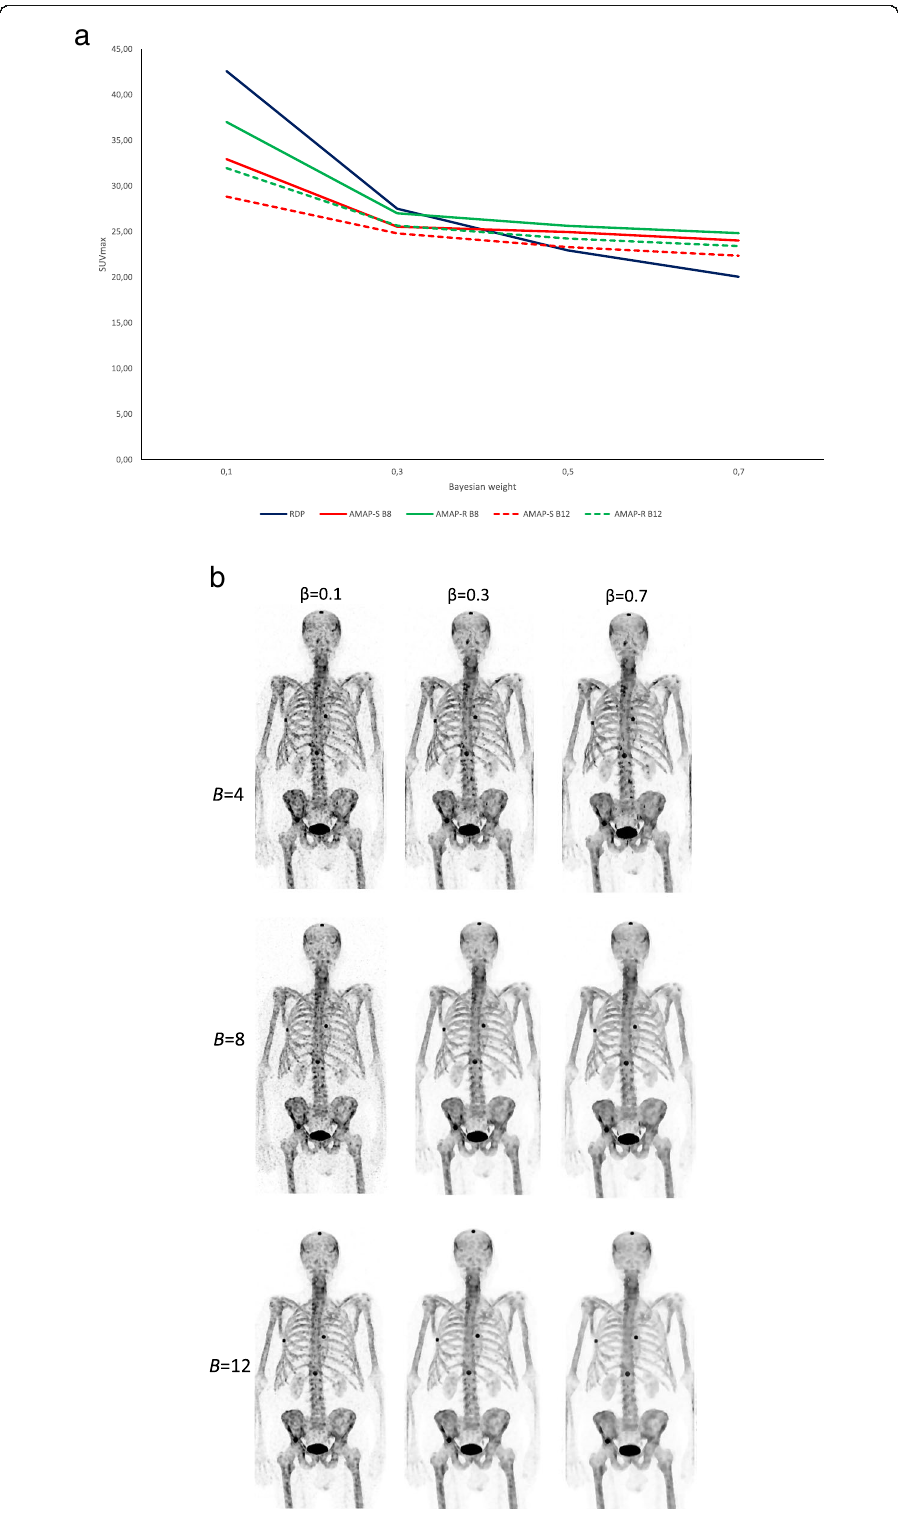
Fig. 1 (See legend on next